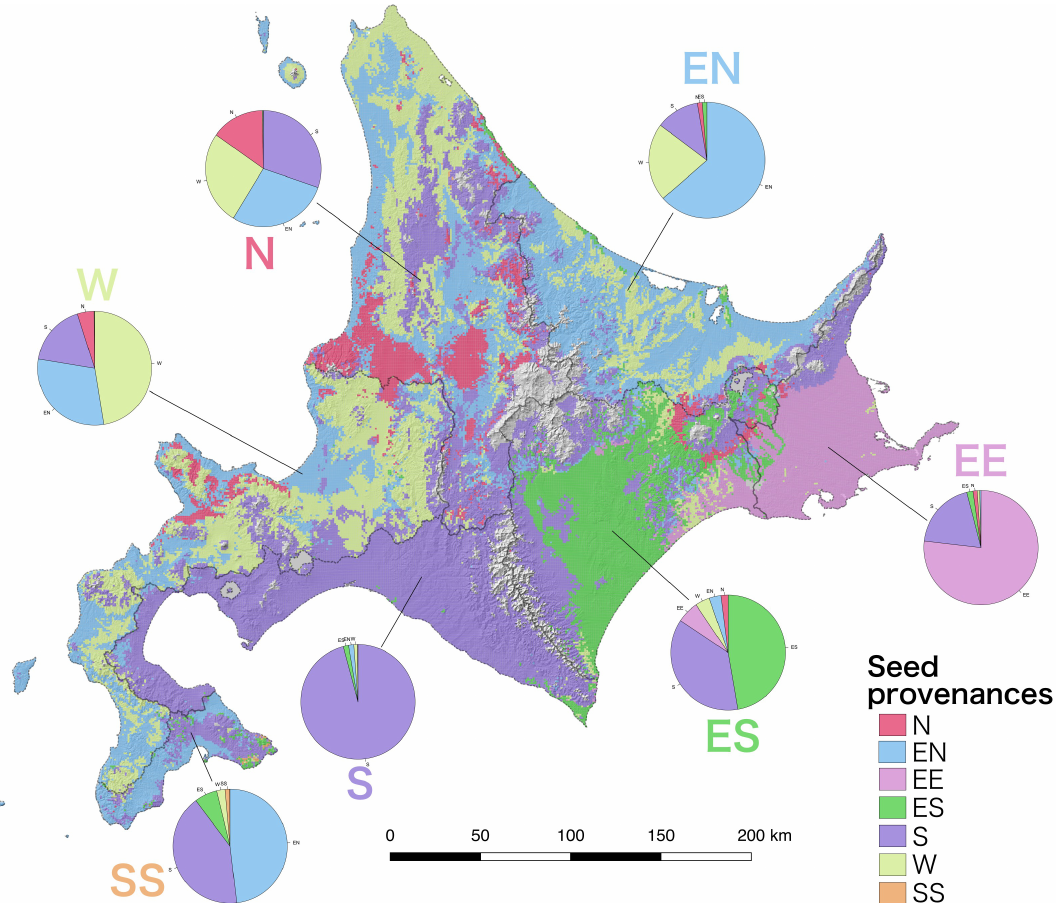
Figure 6. Optimum provenance for planting based on predicted tree height by multivariate random forests. Pie charts show the fraction of areas for which each seed provenance was predicted as optimum in each regional group. Gray area indicates alpine zone with less than 35 in the WI which was excluded from the